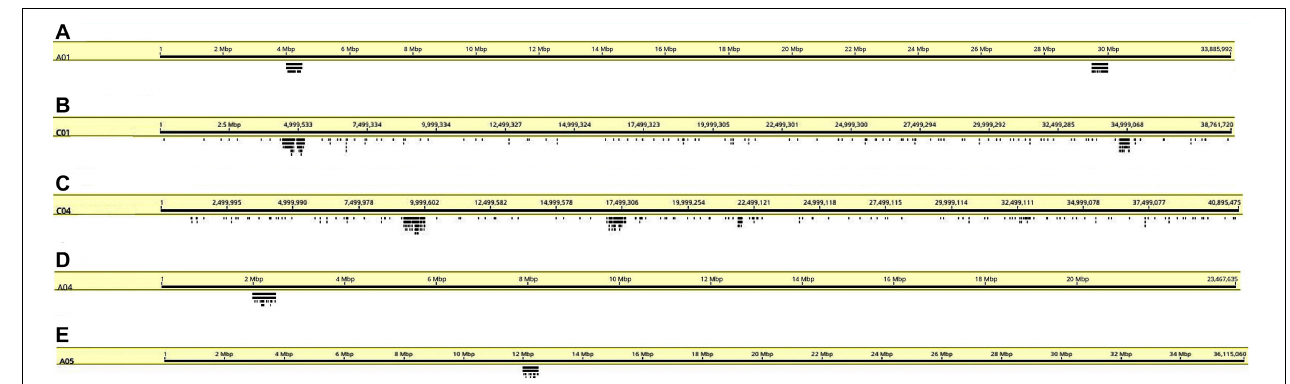
FIGURE 4 | Coverage graphs (stacked bars below chromosomes) depicting hybridization simulations of oligonucleotide libraries made from the B. rapa A genome on chromosomes (A) A01, (B) C01, (C) C04, (D) A04, and (E) A05. Sites are only within target regions on the A genome chromosomes as expected from the design strategy, but a few hybridization sites are seen elsewhere on C genome chromosomes (B,C) .